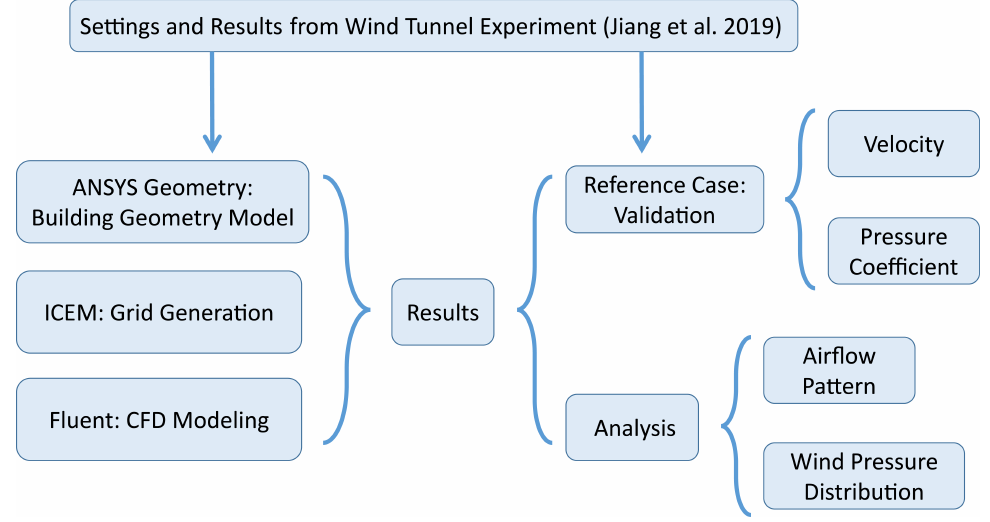
Figure 5. Flowchart for investigating airflow fields of the shaded building.